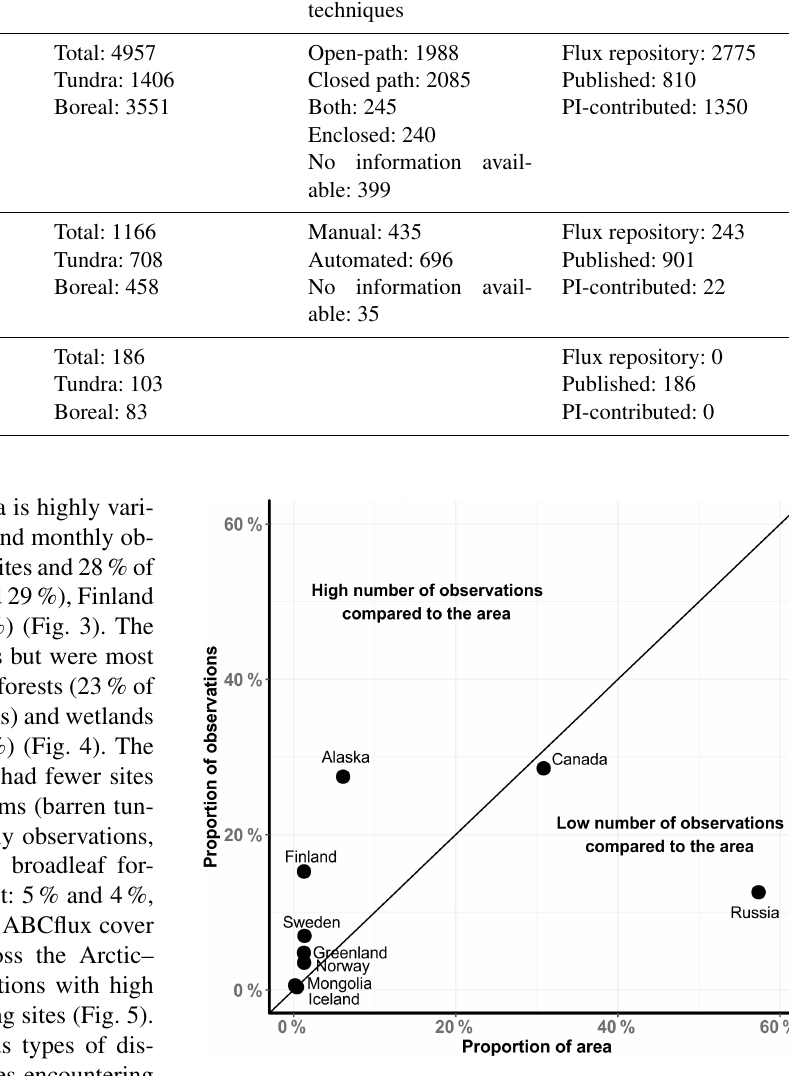
Figure 3. The proportion of monthly observations in each coun- try/region compared to the proportion of the areal extent of the country/region across the entire Arctic–boreal zone. Ideally, points would be close to the 1 : 1 line (i.e., large countries/regions have more observations than small countries/regions). Permanent water bodies, glaciers, croplands, and urban areas were masked from the areal extent